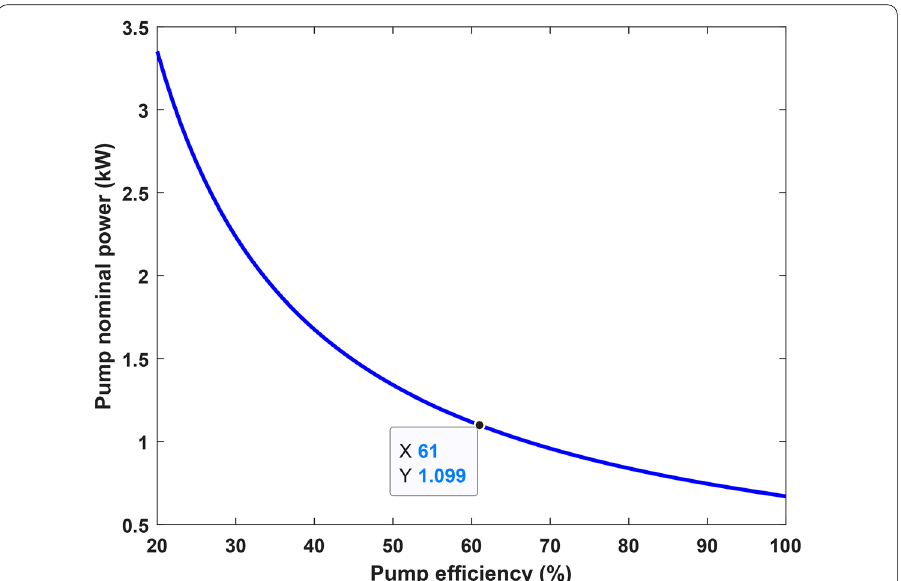
Fig. 16 Influence of pump efficiency on the nominal power of the pump for a water flow rate of 6.15 m 3 and